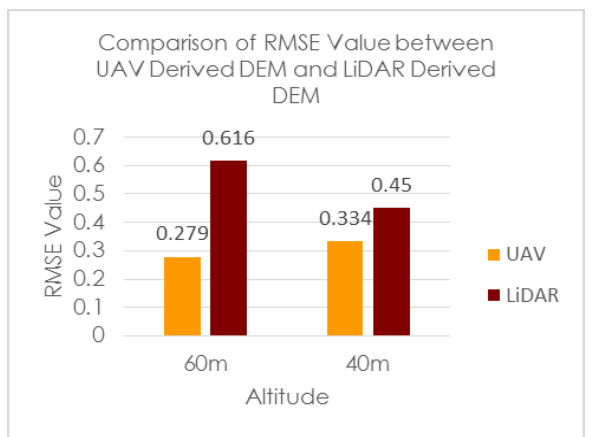
Figure 17. Comparison of RMSE Value between UAV Derived DEM and LiDAR Derived